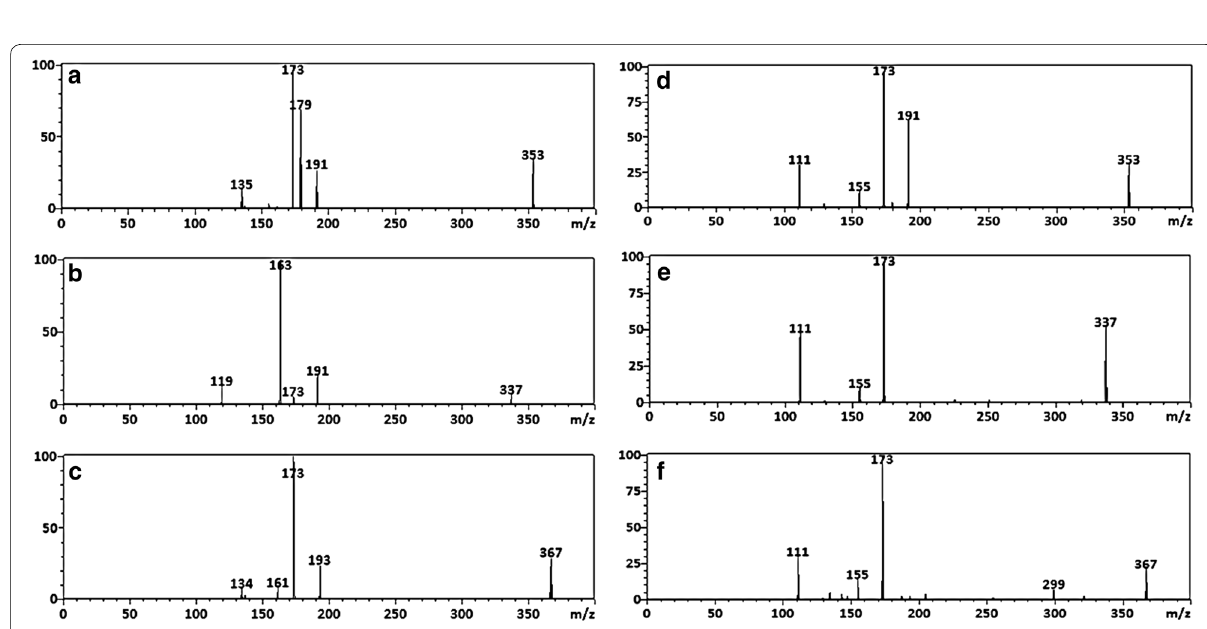
Fig. 2 Typical MS fragmentation patterns of HCAs conjugated to quinic acid ( a – c ) extacted from M. oleifera or isocitric acid ( d – f ) extracted from M. viridis : a 4-caffeoyl-quinic acid, b 4- p -coumaroyl-quinic acid, c 4-feruloyl-quinic acid, d 2-caffeoyl-isocitric acid, e 2- p -coumaroyl-isocitric acid and f 2-feruloyl-isocitric